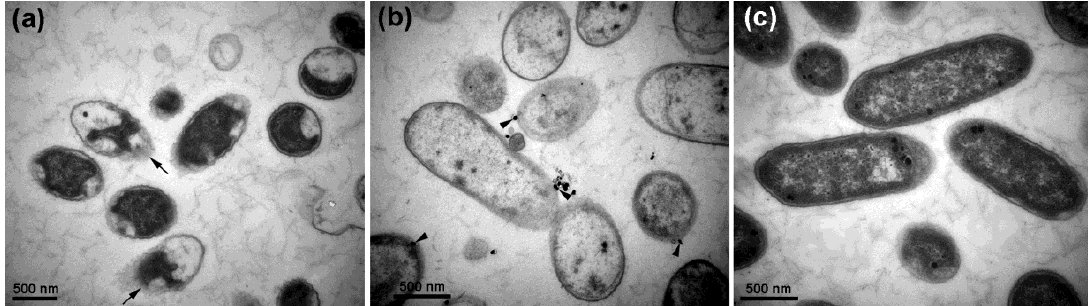
Figure 3. Transmission electron micrographs showing Dickeya dadantii cells treated by silver nanoparticles (50 µ g · mL − 1 ) ( a , b ) and without treatment ( c ). ( a ) Coagulation and collapse of cytoplasm after treatment for 2 h. Arrows point to disintegration of cell envelopes. ( b ) Disintegration and clearing of cytoplasm after treatment for 6 h. Arrowheads point to silver nanoparticles adhering to cell surface. ( c ) Intact cell envelopes and cytoplasm filled in control cells without treatment.